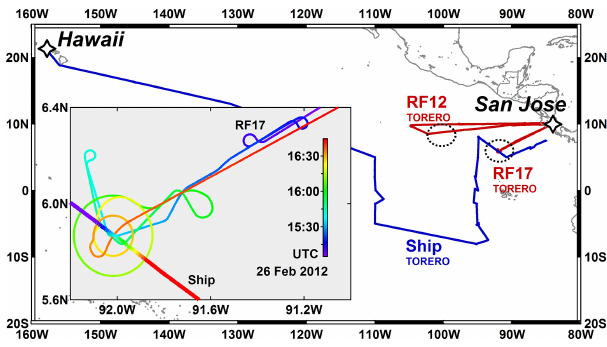
Figure 1. TORERO cruise track (blue line) and GV flight tracks (red lines), where the locations of the RF12 and RF17 profile case studies are indicated (dashed circle). The inset shows the detailed view of the flight track during the instrument intercomparison above the RV Ka’imimoana